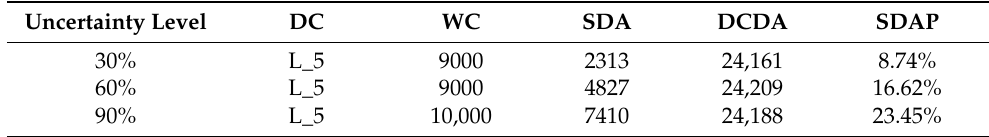
Table 6. Variations in LIRP decisions under different uncertainty levels ( ρ = 1 )